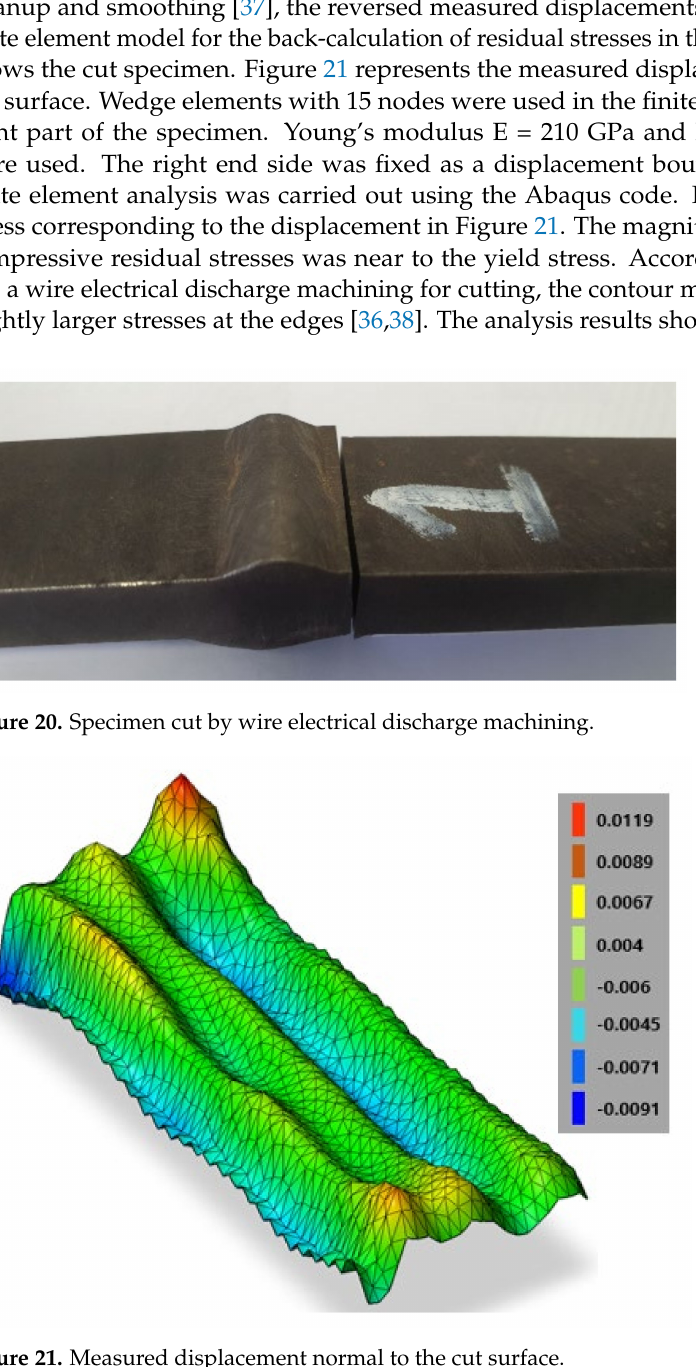
Figure 21. Measured displacement normal to the cut